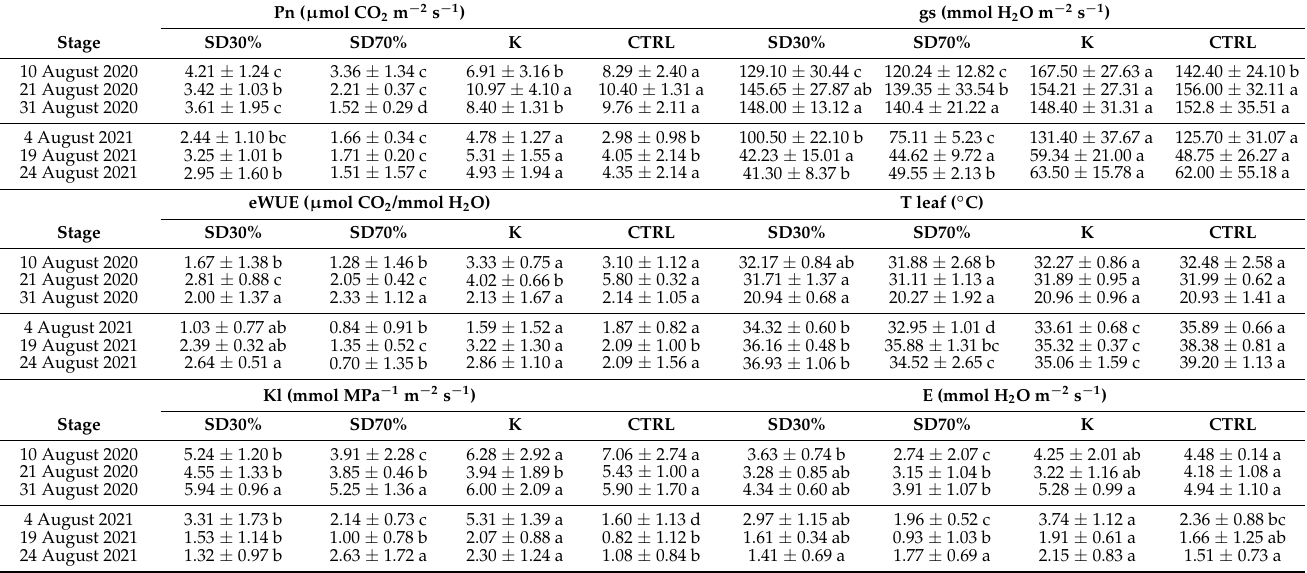
Table 1. Plant physiology. Net photosynthesis (Pn), stomatal conductance (gs), water use efficiency (eWUE), leaf temperature (Tleaf), leaf specific hydraulic conductance (Kl), and transpiration (E) of V. vinifera treated with four different canopy management. Measurements were conducted at full veraison (10 August 2020 and 4 August 2021), mid maturation, berries with intermediate sugar values ± SE, n = 10) were subjected to one-way ANOVA. In each measured parameter (Pn, gs, eWUE, T leaf, Kl, and E) the statistical difference is represented by letters; within the single date, single row, the statistical differences between the treatments (SD30%, SD70%, K, and CTRL) are represented by different letters (a, b, c) (LSD test, p ≤ 0.05). The same letter pictured on different treatments indicates no significant difference among